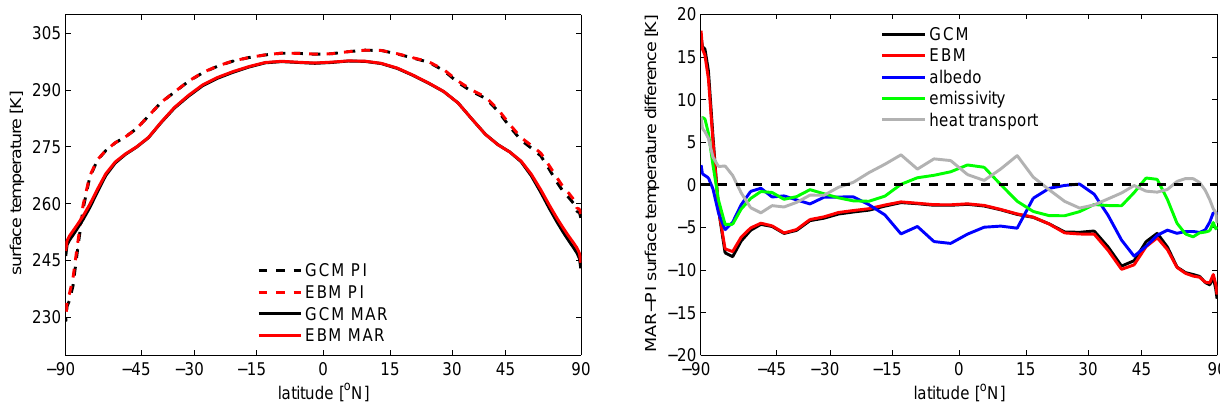
Fig. 4. Left: time and zonally averaged surface temperature of MAR (solid) and PI (dashed) as simulated by the atmosphere-ocean general circulation model (GCM, black) and diagnosed by the one-dimensional energy balance model (EBM, red). Right: difference of time and zonally averaged surface temperature between MAR and PI as simulated by the general circulation model (black) and diagnosed by the one- dimensional energy balance model (red). The other solid lines show the MAR-PI surface temperature differences attributed to differences in planetary albedo (blue), effective emissivity (green), and heat transport (gray). The abscissae are linear in sine of latitude.